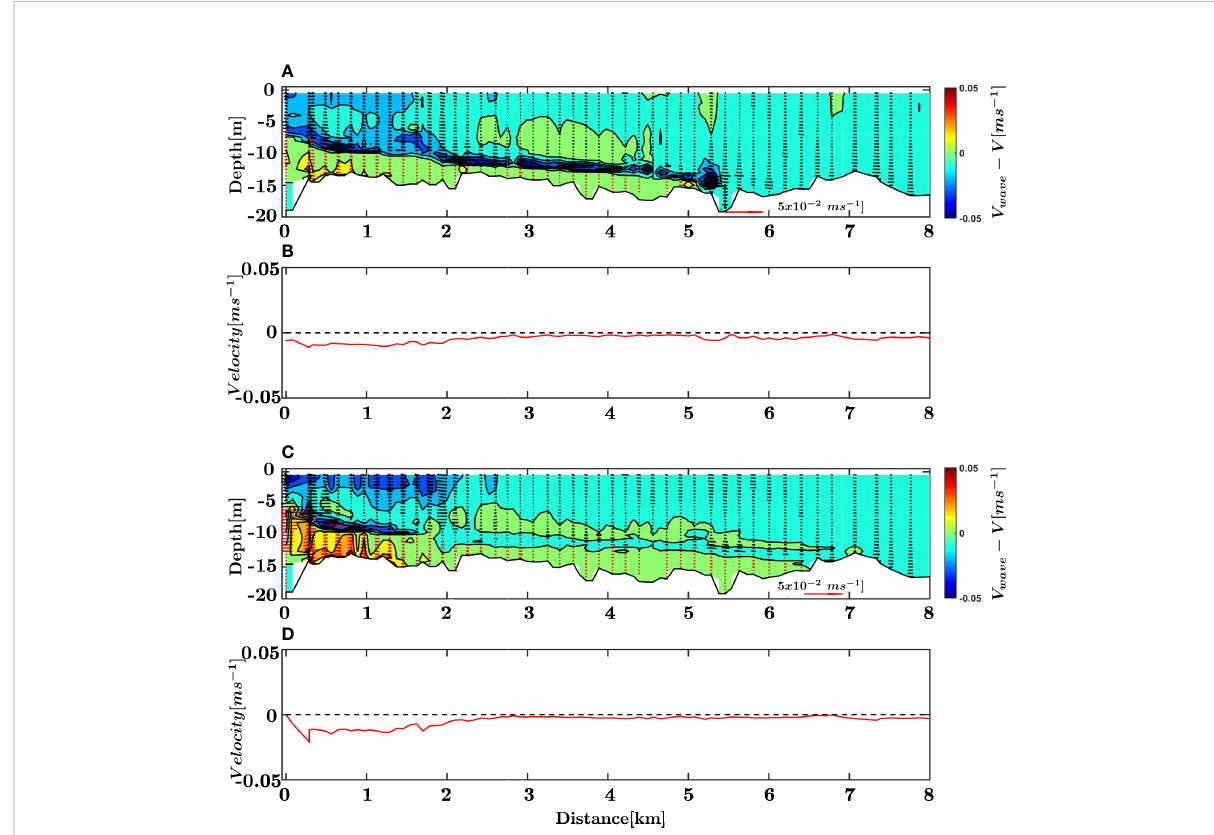
FIGURE 7 Difference in longitudinal velocity distribution, with and without waves, averaged over a spring tidal cycle: (A) Dry season, 2018 and (C) Dry season, 2020. (Black and red vectors indicate the difference in river and salt wedge velocity, respectively). Differences in vertically averaged velocity along the estuary for the (B) Dry season, 2018 and (D) Dry season, 2020. (Flow to the sea is considered positive, while fl ow to the river is considered